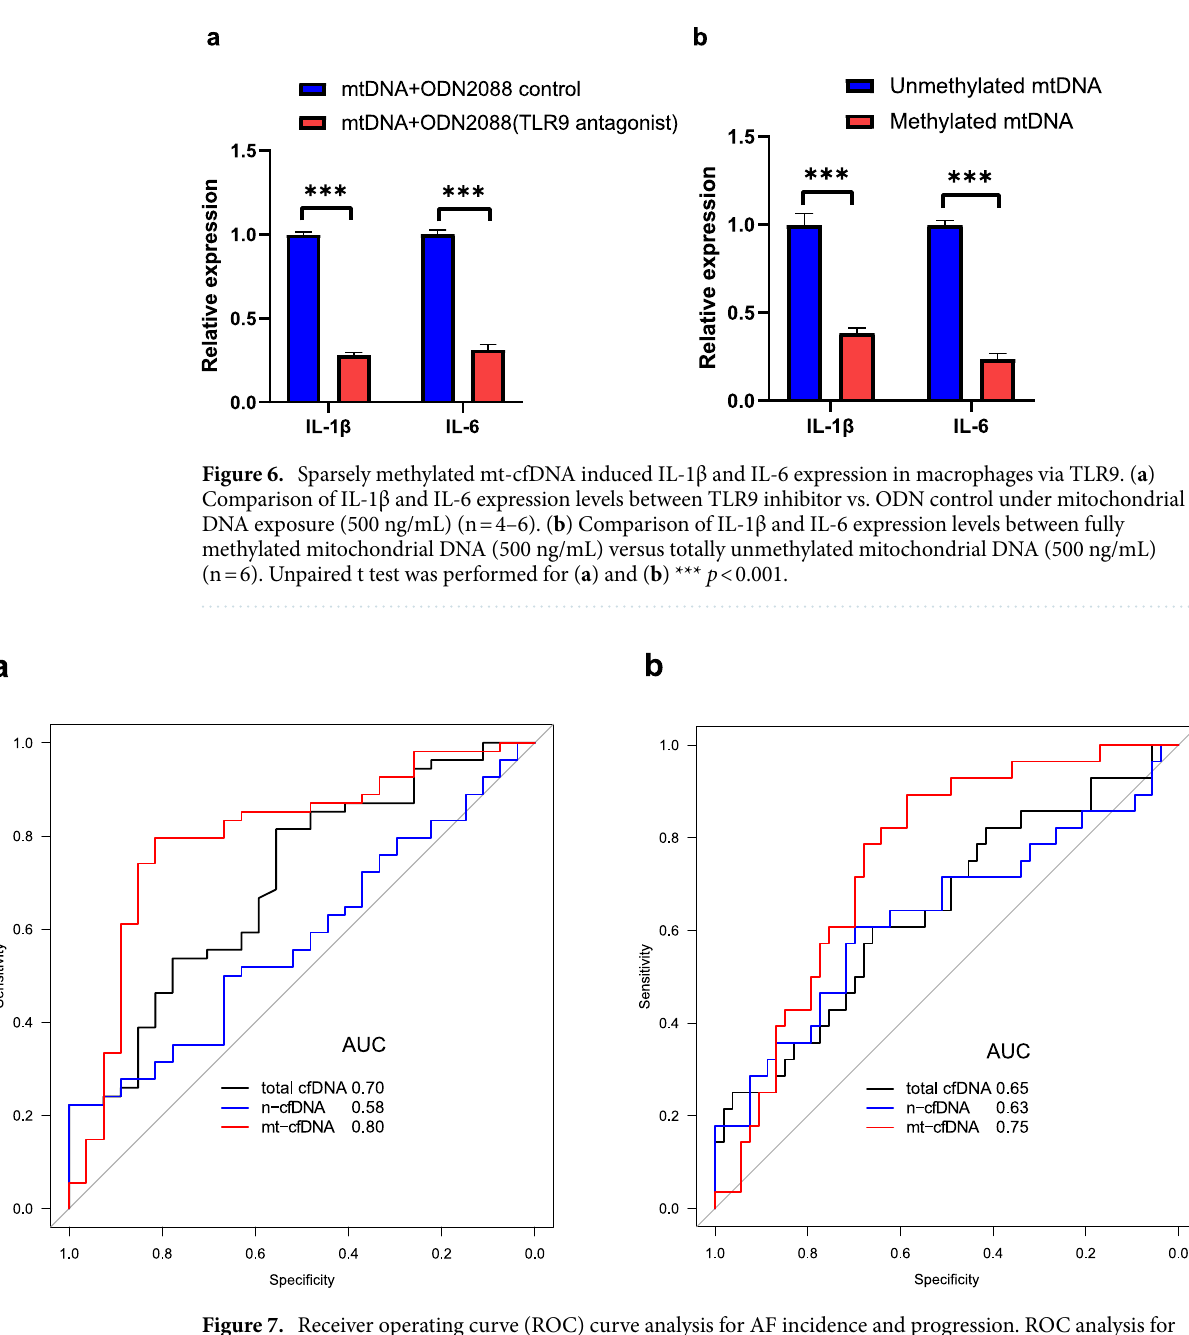
Figure 7. Receiver operating curve (ROC) curve analysis for AF incidence and progression. ROC analysis for AF incidence ( a ) (non-AF vs. AF), and for AF progression ( b ) (non-AF and paroxysmal AF vs. persistent AF) using total cfDNA, n-cfDNA, and mt-cfDNA. AUC, area under the